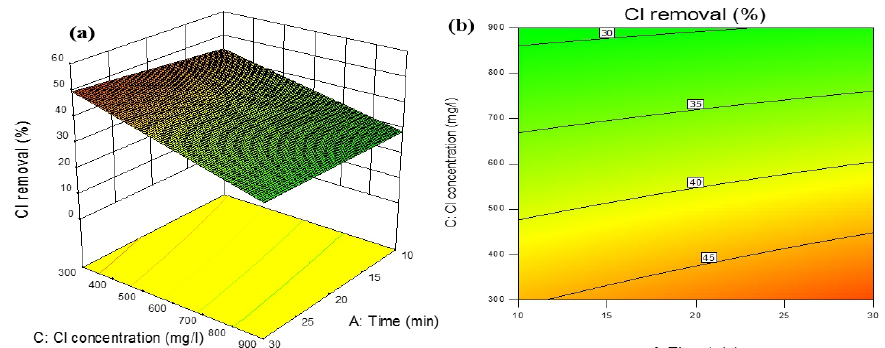
Fig. 6. Effects of Cl − ion initial concentration and process runtime on Cl − ion removal rate (%); a) 3-D plots, b) 2-D contour plots